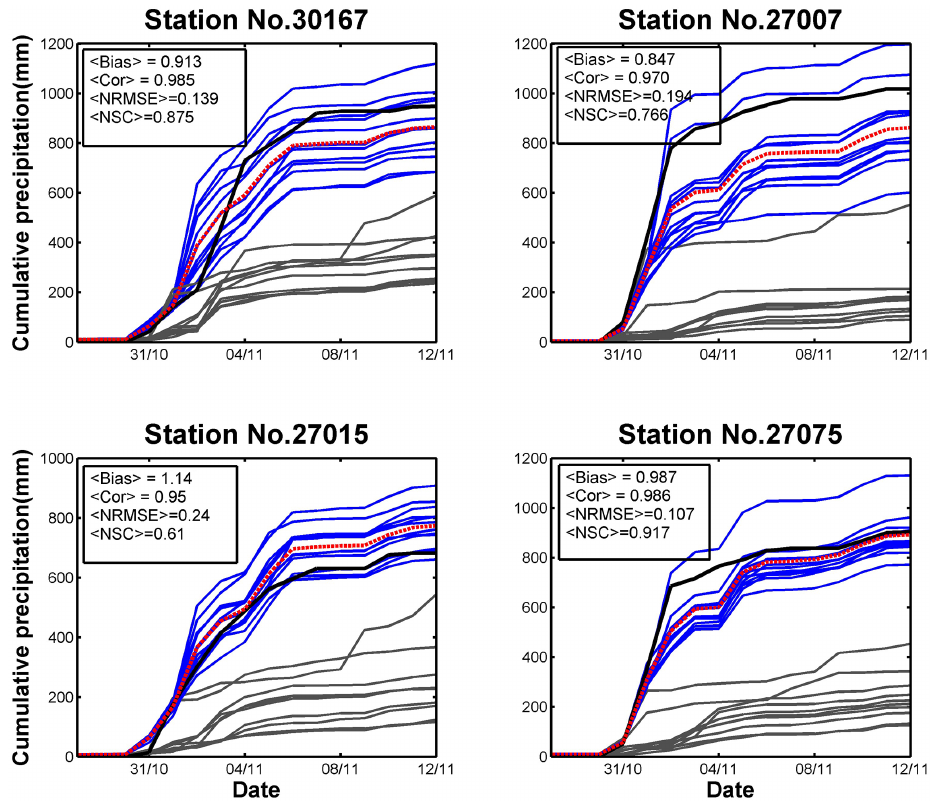
Figure 3. Comparison of cumulative precipitation estimated by the 23 model runs of the WRF multi-physics ensemble. Blue solid line: selected members with NSC > 0.3; grey solid line: disregarded members with NSC < 0.3; red dotted line: mean of the selected 12 members; black solid line: measurements at each of the four weather stations from 27 October 2009 to 12 November 2009.